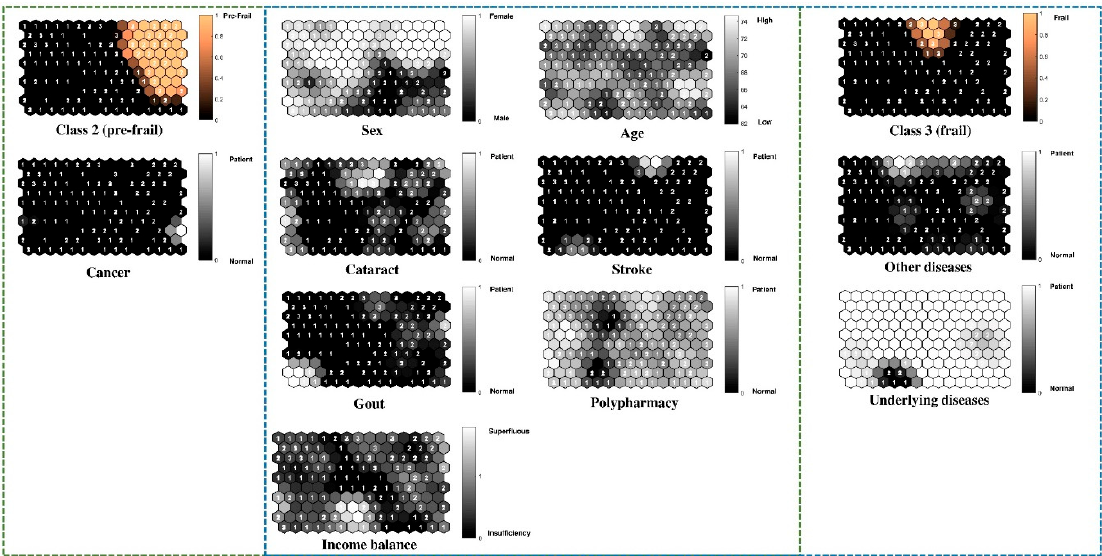
Figure 4. Component planes of the pre-frail and frail groups and their significant variables for the trained SOM model.